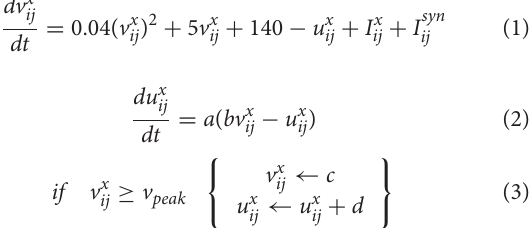
Table 1 . The Izhikevich model consists of two variables, one for membrane potential ( v x ) and the other one for membrane recovery variable ( u x